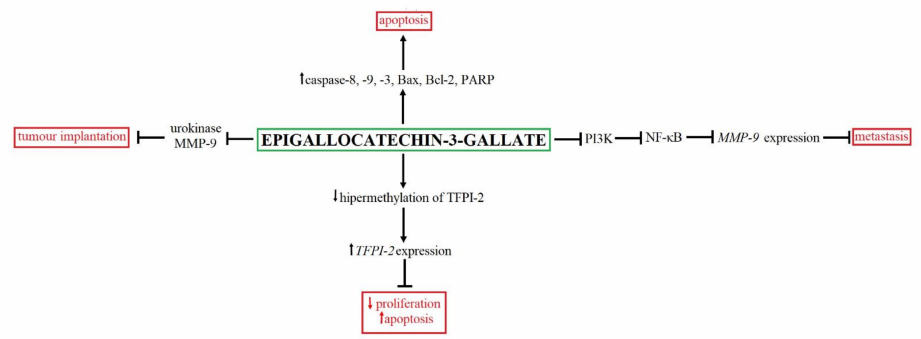
Figure 5. The summary of anticancer effects and mechanism of EGCG action. EGCG may modulate numerous signaling pathways, including cell proliferation [116], metastasis [113,117,118] as well as apoptosis